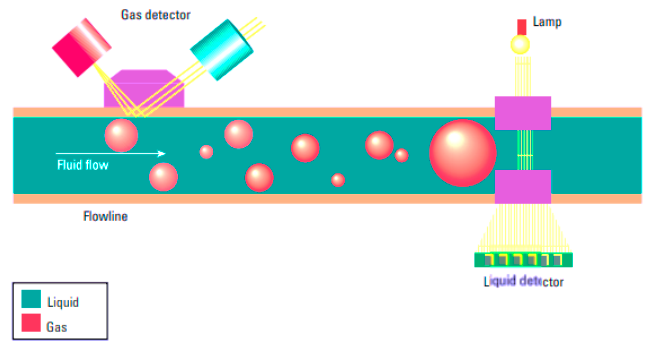
Figure 7. MDT performance diagram [57].